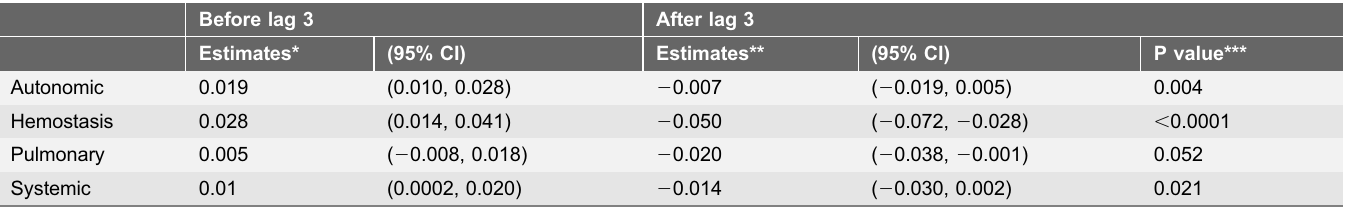
z v z p 1 w b 1 p . 1 z v z p z m z v z p 1 w b 1 p 2 w b 2 p 1 2